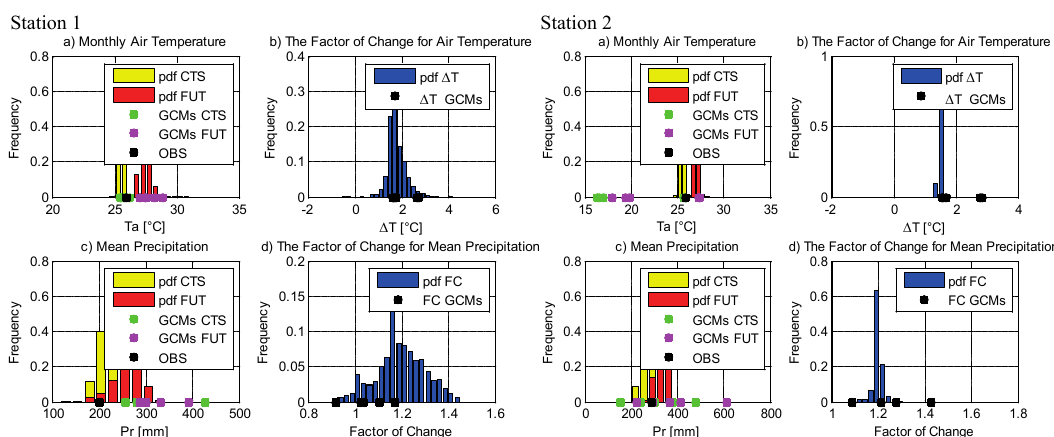
Fig. 3 The posterior probability density functions (PDF) of mean temperature and precipitation obtained from the multi-model ensemble for all stations, for November.